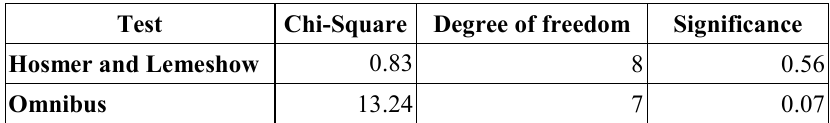
Table 2. Hosmer and Lemeshow Goodness Test and Omnibus Test Results Test